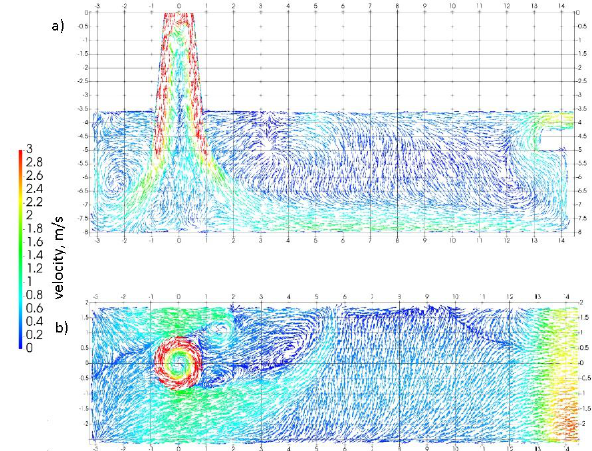
Figure 7: The distribution of the velocity vectors in the outlet cham-